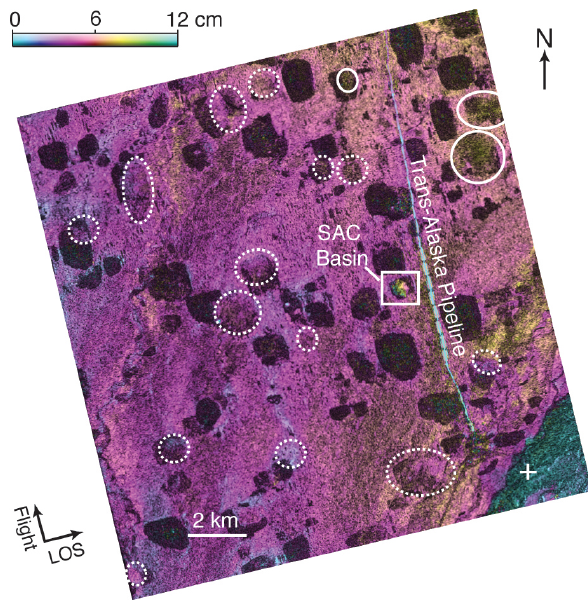
Fig. 3. An example interferogram showing seasonal thaw settlement of DTLBs and surroundings. Color indicates the surface thaw set- tlement between 13 June 2007 and 13 September 2007, projected in the satellite line-of-sight (LOS) direction, with the reference point located on the river floodplain (white cross). The white box marks SAC basin that underwent a strong settlement compared with the surrounding area. Solid circles outline DTLBs with stronger sea- sonal settlement than the surrounding tundra, and dashed circles outline DTLB with similar seasonal settlement as the surroundings. DTLBs smaller than 4ha or having low interferometric coherence are not marked. The satellite flight and LOS directions are shown in the lower left.